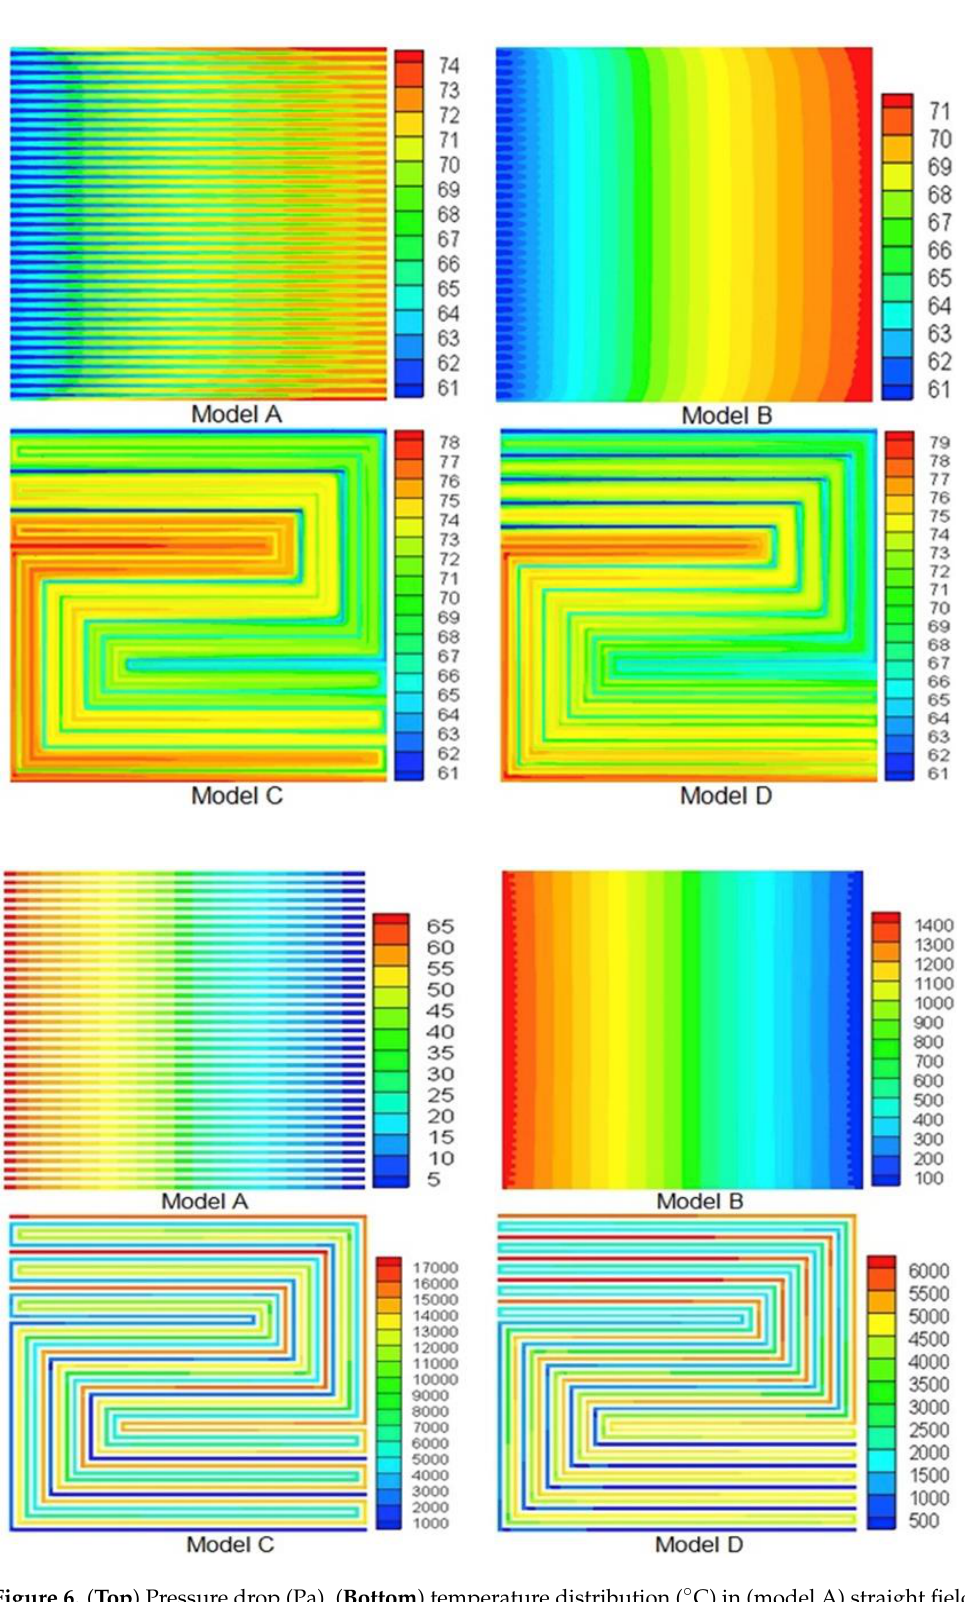
Figure 6. ( Top ) Pressure drop (Pa), ( Bottom ) temperature distribution (°C) in (model A) straight field with 37 parallel paths, (model B) metal foam structure flow field with 37 coolant inlets, (model C) a multi-pass serpentine flow field (MPSFF) with three parallel paths, and (model D) MPSFF with five parallel paths [123] (license no. 5172500594532).